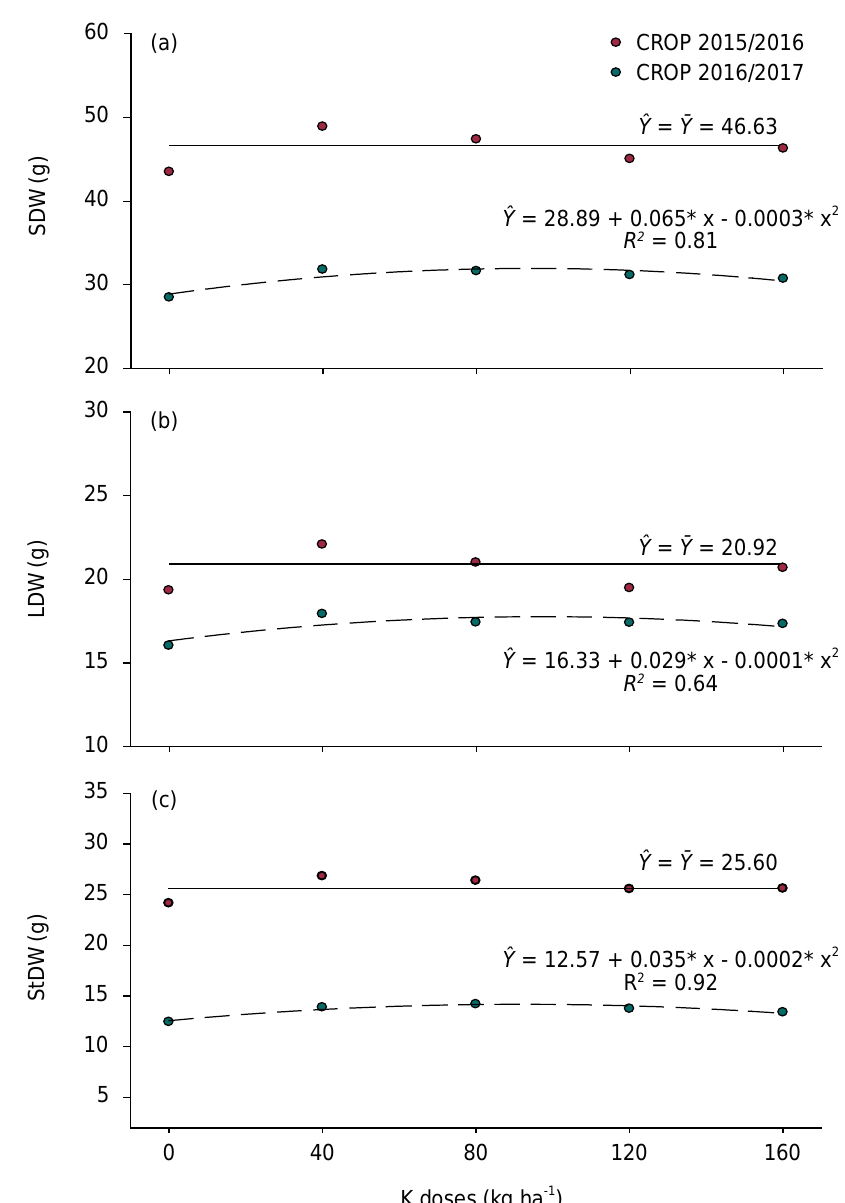
Figure 2. Shoot dry weight (SDW) (a), leaf dry weight (LDW) (b), and stem dry weight (StDW) (c) of soybean for the crops in 2015/2016 and 2016/2017 after the application of different K rates. * = significant at 5